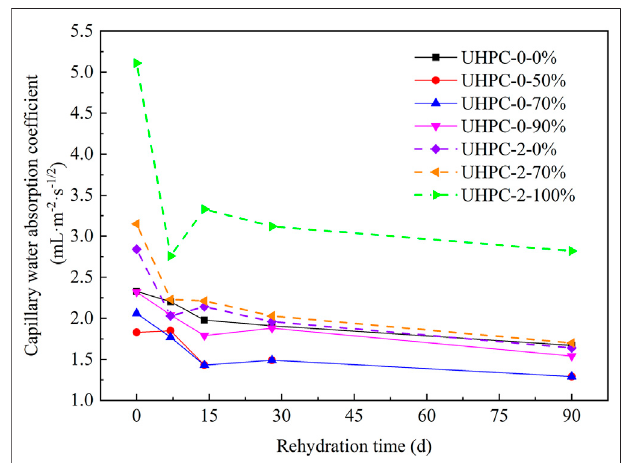
FIGURE 10 | Capillary water absorption coef fi cients of UHPC-0 and UHPC-2 with increasing rehydration time.